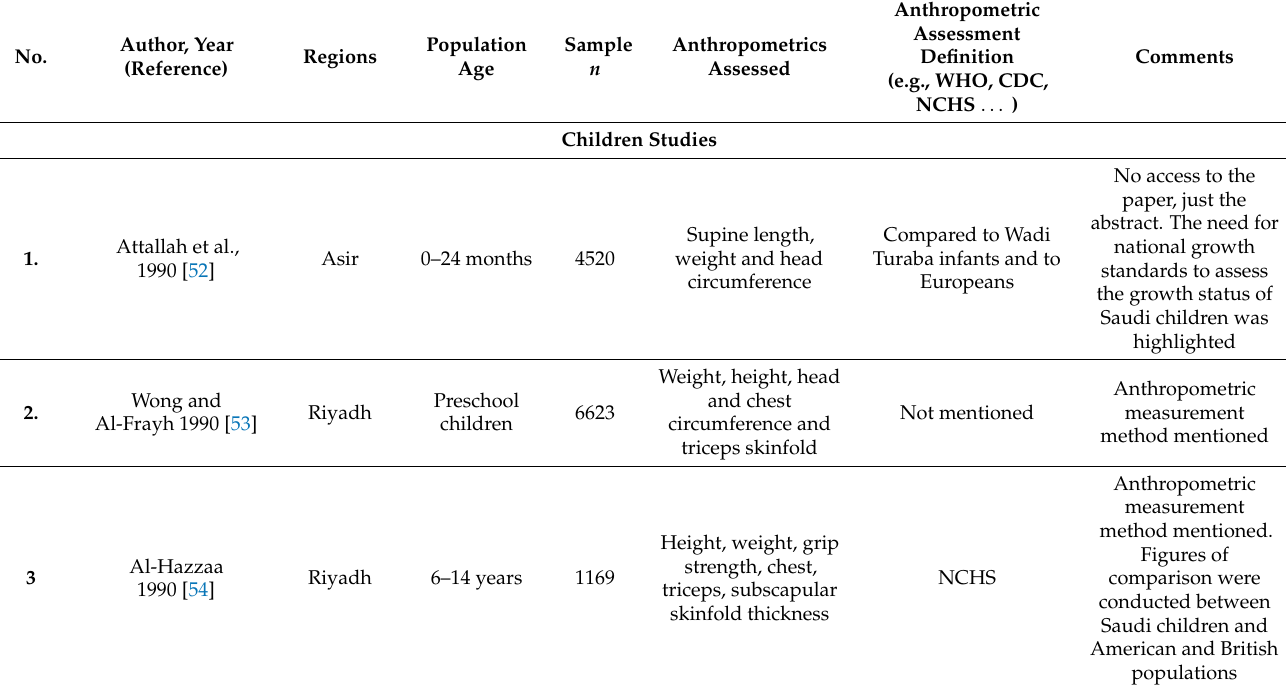
Table 2. Saudi children/adolescent studies measuring